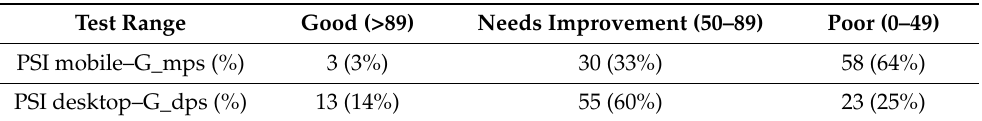
Table 5. Results of Google PageSpeed Insights (PSI) performance tests.